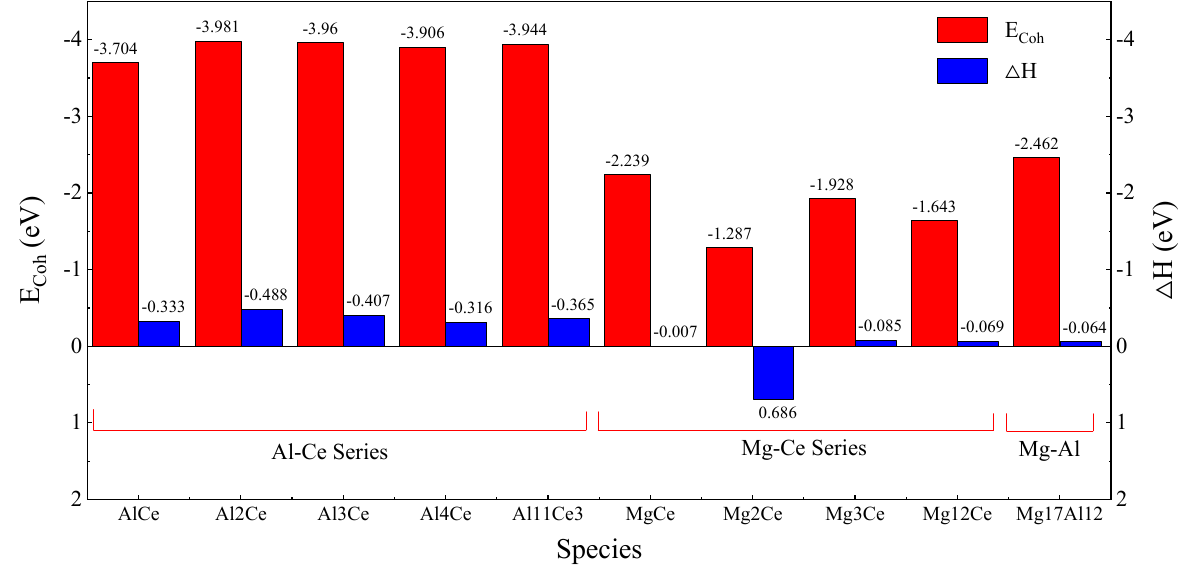
Figure 2. The contrast of E Coh and △ H among Al-Ce, Mg-Ce, and Mg-Al phases. The alloying reaction sequence of the Mg-Al-Ce ternary alloy system was deduced by comparing the E Coh and △ H results of the Mg-Ce series, Al-Ce series, and Mg-Al series intermediate phases. Since Ce had the strongest alloying ability, Ce was preferentially alloying with Al or other elements with a higher electronegativity difference (if any) to form a rare earth phase, until a certain element was exhausted. While, the remaining alloying elements reacted again, according to their alloying ability, until solidification. Combined with the addition of a small amount of Al (about 3 wt.%) and Ce (<1 wt.%) in this work, it could be inferred that the main precipitations of the Mg-Al-Ce ternary alloy were Al-Ce phase and Mg-Al phase. In addition, Ce element was added in a form of Mg-Ce master alloy at 750 °C, which obviously did not meet the formation conditions of Al 2 Ce and Al 3 Ce Al; hence, the main Al-Ce intermediate phase was Al 11 Ce 3 , with a formation pathway